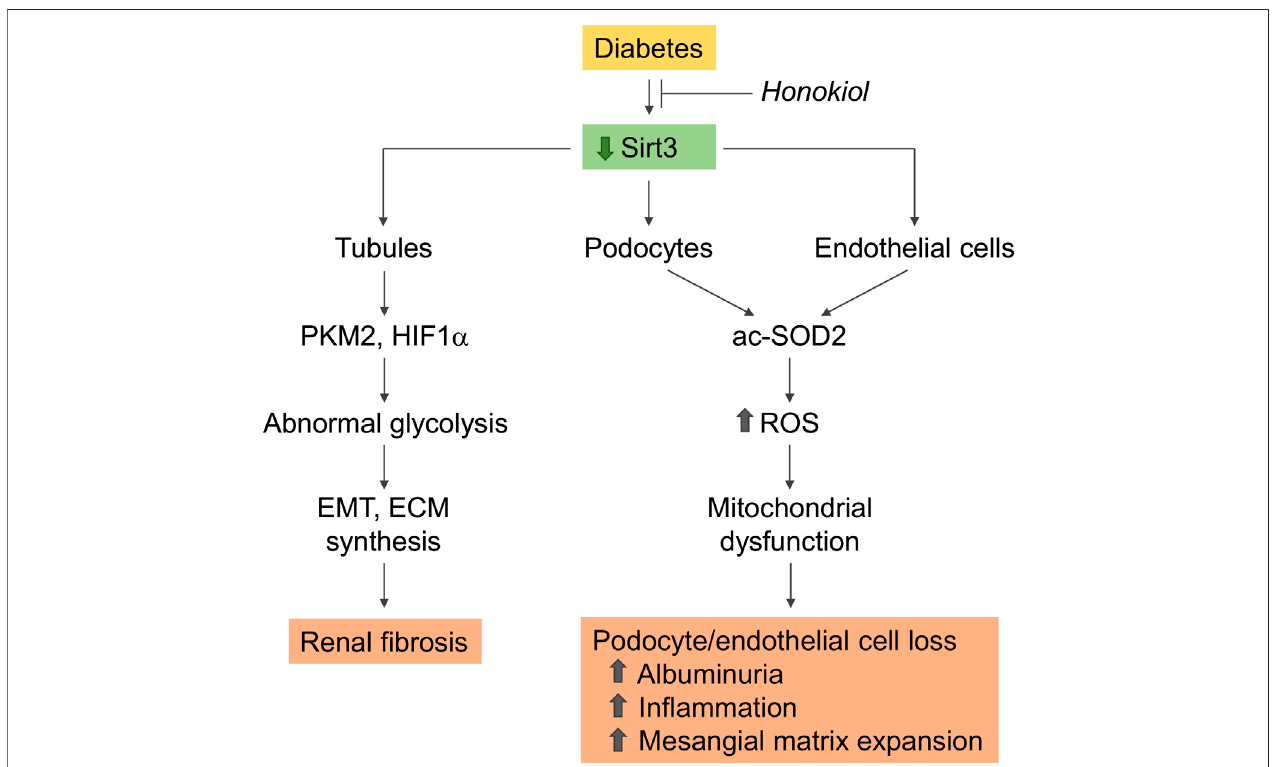
FIGURE 2 | Role of sirtuin-3 dysregulation in kidney disease progression in diabetes. Sirtuin-3 is downregulated in the diabetic kidney. Reduced expression in podocytes and glomerular endothelial cells impairs SOD2 antioxidant activity as a consequence of enzyme acetylation, resulting in increased ROS generation, which promotes mitochondrial dysfunction and cell loss. These changes contribute to the development of albuminuria associated with in fl ammation and mesangial matrix expansion.Renaltubuleswithreducedsirtuin-3undergoametabolicreprogrammingwithashifttowardabnormalglycolysis,displayEMT,andacquireapro fi brotic phenotype. Rescuingsirtuin-3 bythespeci fi c activator honokiolprevents glomerular and tubuledysfunction and ameliorates diabetic nephropathy. acSOD2, acetylated SOD2; PKM2, pyruvate kinase isozyme M2; EMT, epithelial to mesenchymal transition; ECM, extracellular matrix.